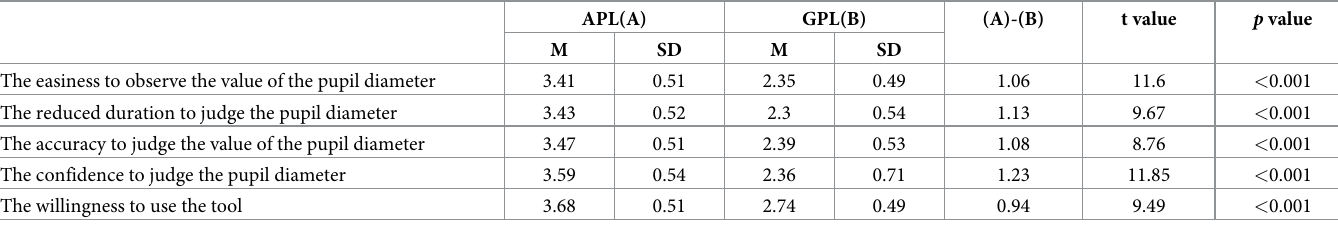
Table 5. Comparison of participants’ opinions of using the APL and the GPL (N =